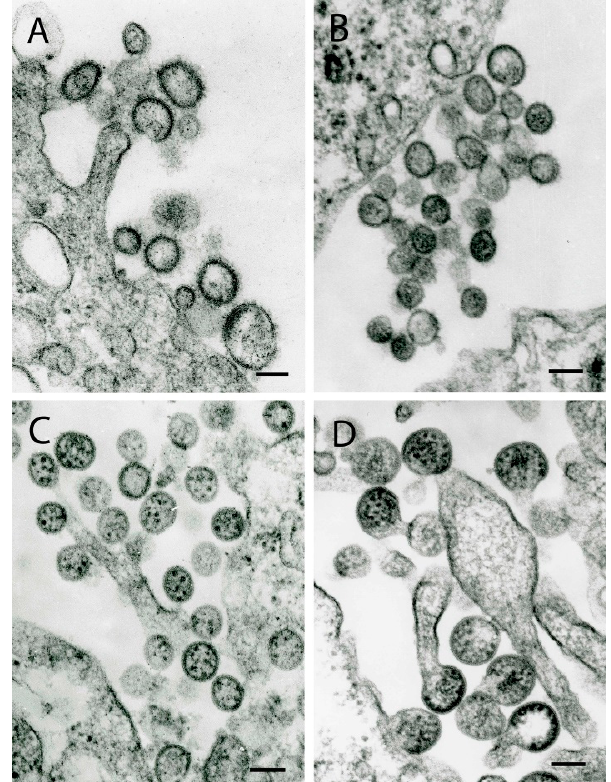
Figure 3. Ultrastructure of tick-borne viruses that are probable members of the family Orthomyxoviridae . ( A ) Aransas Bay virus (unclassified; probable genus Thogotovirus ). Virions 95–200 nm in diameter at the surface of a Vero E6 cell. ( B ) Upolu virus (unclassified; probable genus Thogotovirus ). A group of virions 75–95 nm in diameter at the surface of a Vero E6 cell. ( C ) Wellfleet Bay virus (unclassified; probable genus Quaranjavirus ). Virions 95–115 nm in diameter at the surface of a BHK cell. ( D ) Tjulok virus (unclassified; probable genus Quaranjavirus ). Virions 140–160 nm in diameter forming from the surface of a BHK cell. Bars = 100